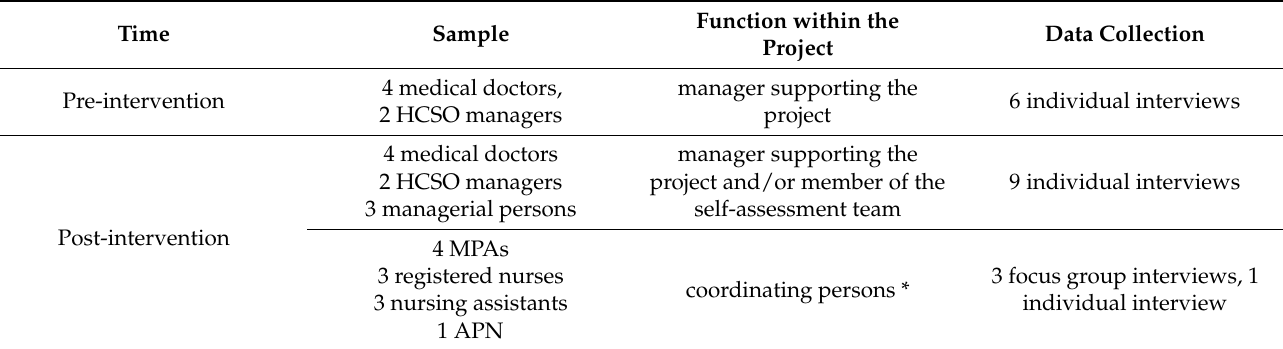
Table 1. Description of sample and data